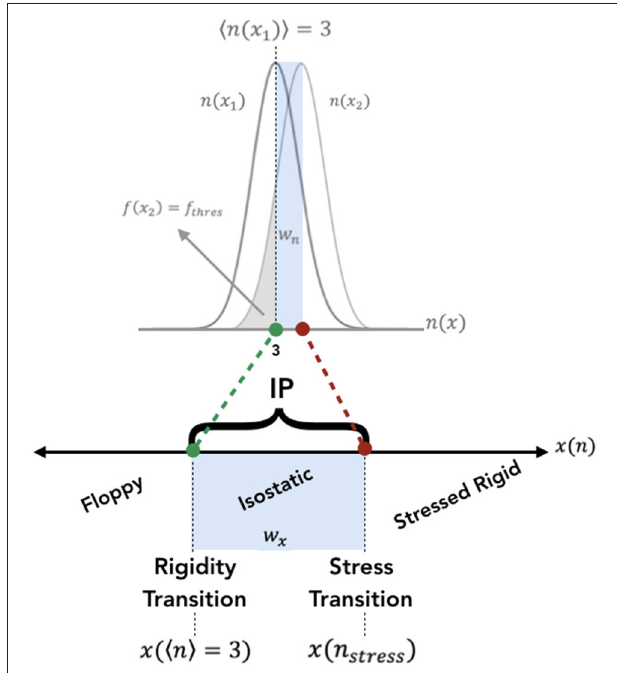
FIGURE 3 | A visual representation of the thresholds that determine the width of the IP, both in terms of the atomic constraints, n ( x ), and the composition, x ( n ). Within his paper, the constraints are given as a distribution, hence incorporating the statistical fluctuations of constraints. The rigidity transition is determined by the composition in which the constraint distribution satisfies h n i = 3. The stress transition is determined by the composition corresponding to the constraint distribution of n stress